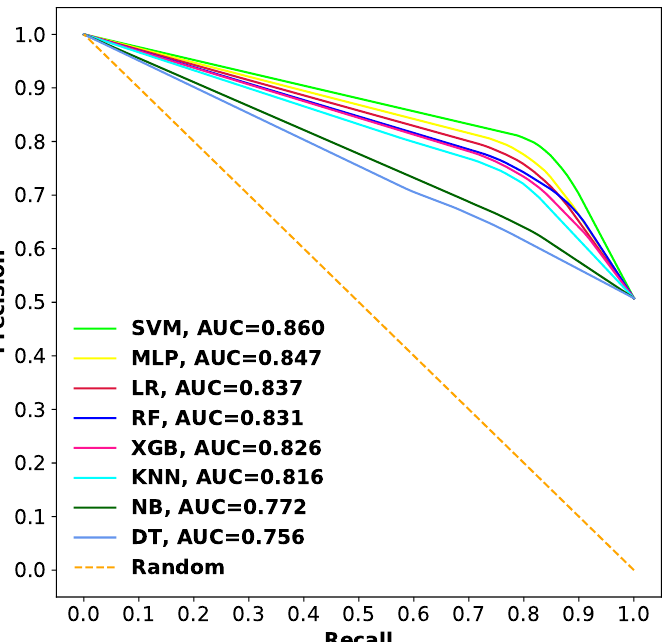
Figure 10. PRC comparison of different classifiers with corresponding AUC values using 10-fold